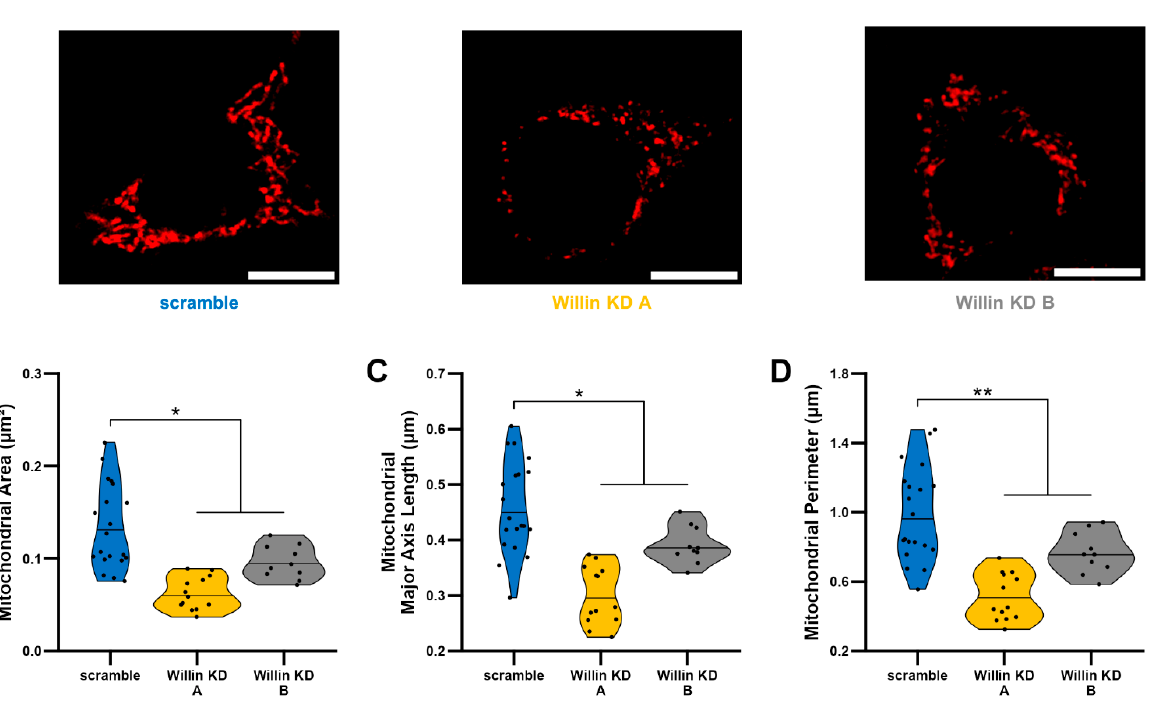
Figure 3. Willin/FRMD6 knockdown leads to mitochondrial fragmentation. Mitochondrial morphological and network abnormalities in Willin KD cells. HT-22 cells were labeled with TMRM for visualization of mitochondria morphology. ( A ) Representative images of TMRM staining. Scale bar = 10 μ m. ( B – G ) Quantitative measurement of mitochondrial morphological ( B – D ) and network parameters ( E – G ) using MitoSegNet for segmentation and analysis. n = 10-20 fields of view (FOV) per condition with 10-50 cells per FOV. Dots represent means per FOV. * p < 0.05. ** p < 0.01. *** p < 0.001.